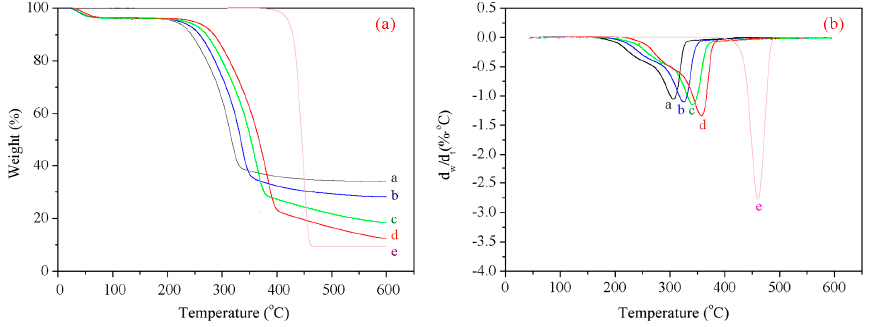
Figure 6. ( a ) TG and ( b ) DTG curves obtained for the unmodified and modified wood fibers;